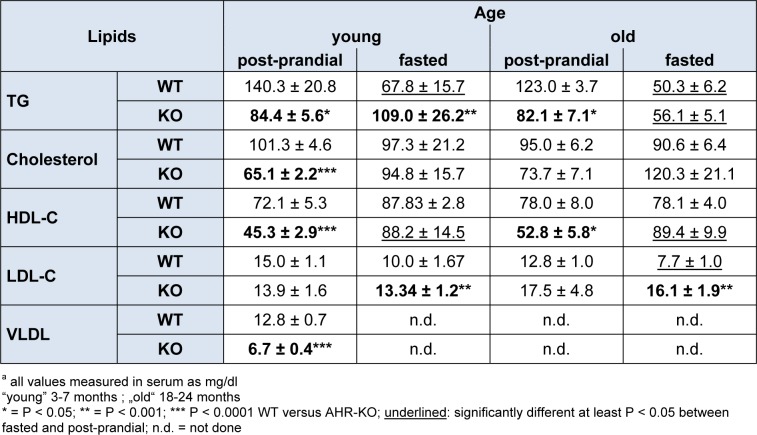
Lipids in seruma